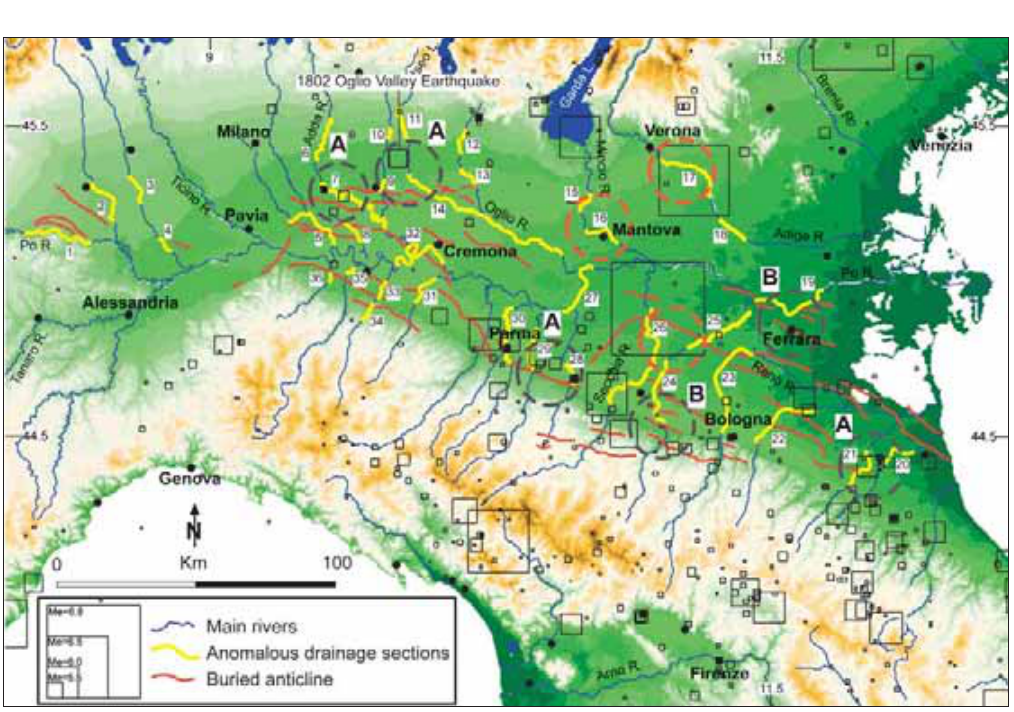
Fig. 5. Distribution of drainage anomalies in the Po Plain (marked in yellow). Dashed black circles labelled A outline areas where an anomaly, a fold axis, and a historical earthquake coincide. Dashed black circles labelled B indicate areas where surface evidence corresponds to buried anticlines, but no historical earthquakes are reported. Dashed red circles highlight areas that require further investigations: see text for discussion. Drainage anomalies are numbered according to table